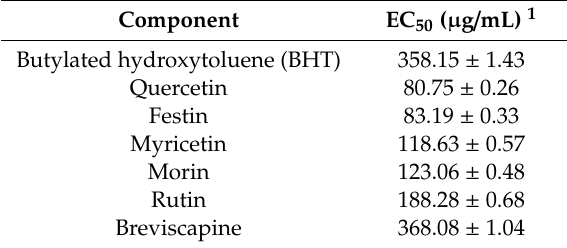
Table 2. 1,1-diphenyl-2-picrylhydrazyl (PPH) radical scavenging activity of